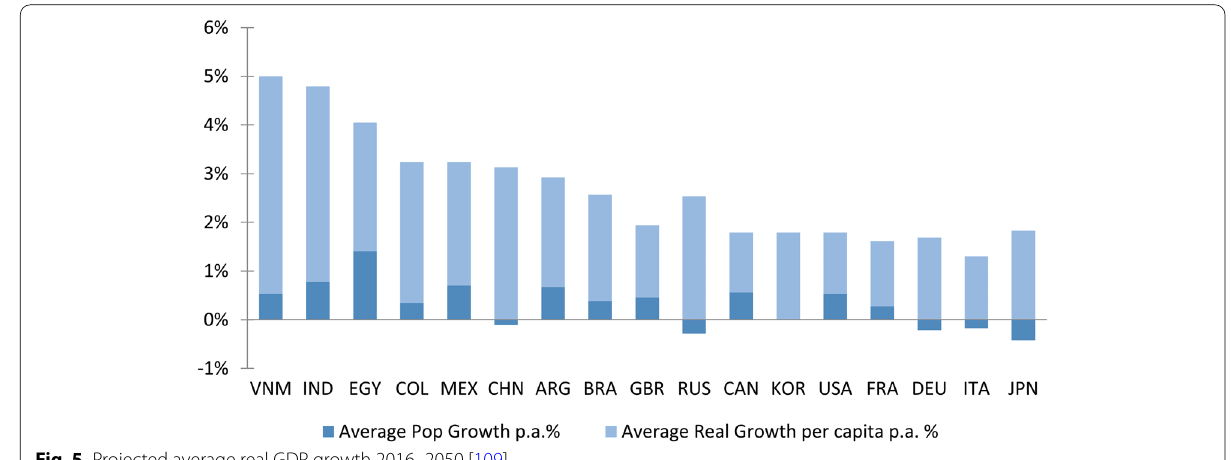
Fig. 5 Projected average real GDP growth 2016–2050